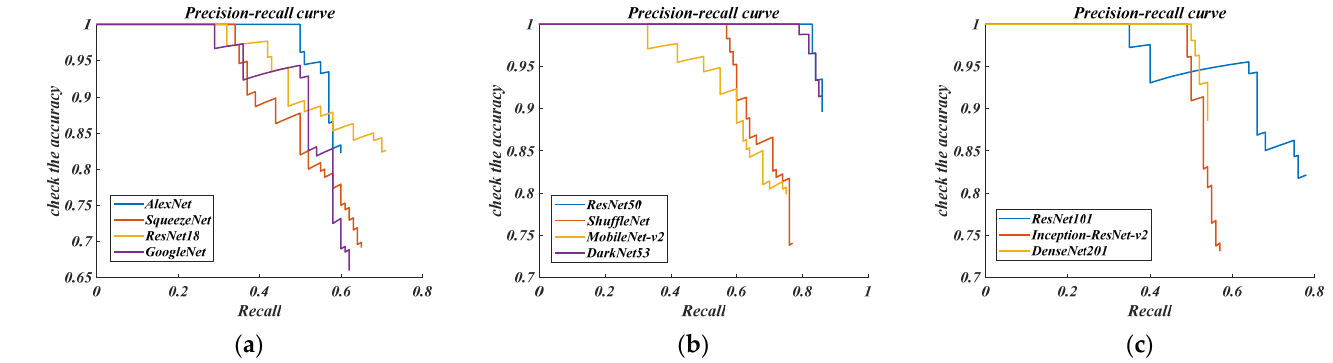
Figure 9. Precision and recall (PR) curve in this research. ( a ) Lightweight network; ( b ) Robust network; ( c ) Complex network.